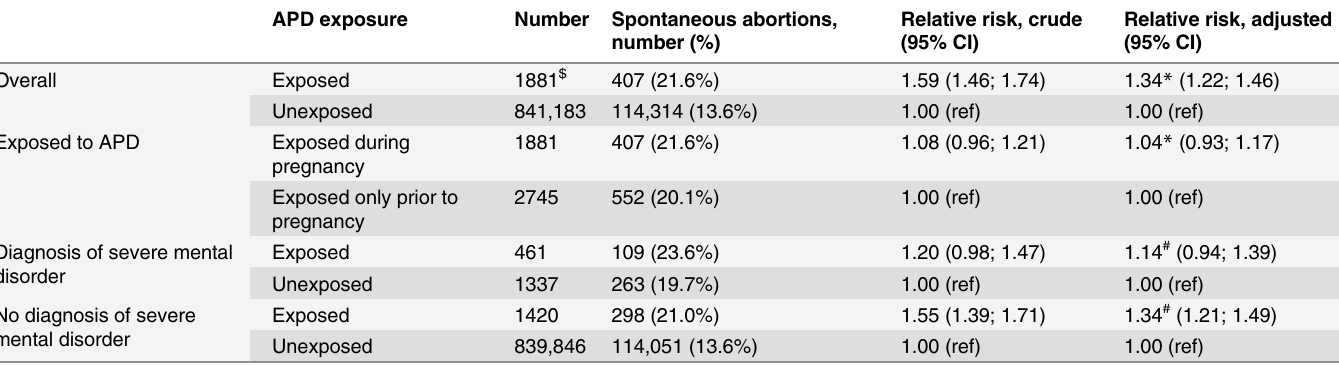
Table 2. Relative risks of spontaneous abortion following APD exposure in pregnancy (numbers refer to pregnancy outcomes studied).